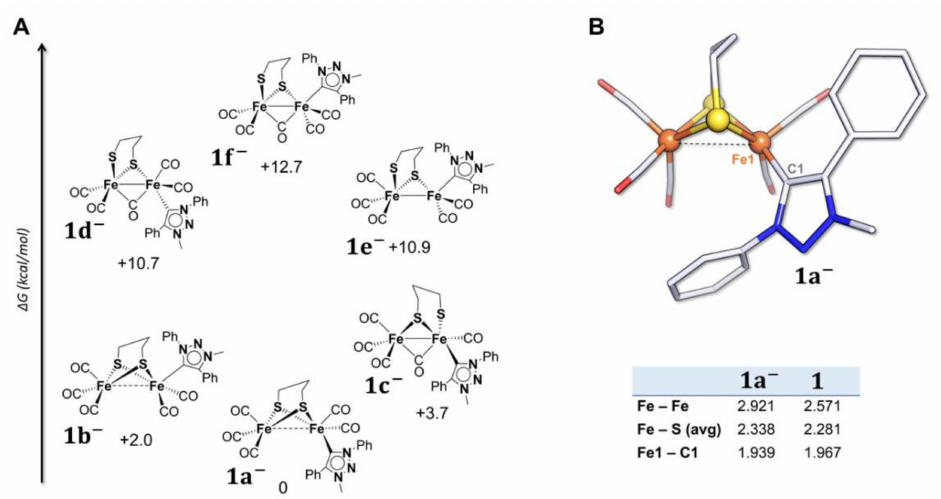
Figure 2. ( A ) Thermodynamic speciation of 1 − and ( B ) optimized structure of 1a − with relevant geometrical parameters (distances in Å) in comparison with the ones of 1 . Atom coloring: Fe = orange, S = yellow, C = grey, N = blue, and O = red. H atoms are omitted for clarity. For simplification, net charges on structures are not